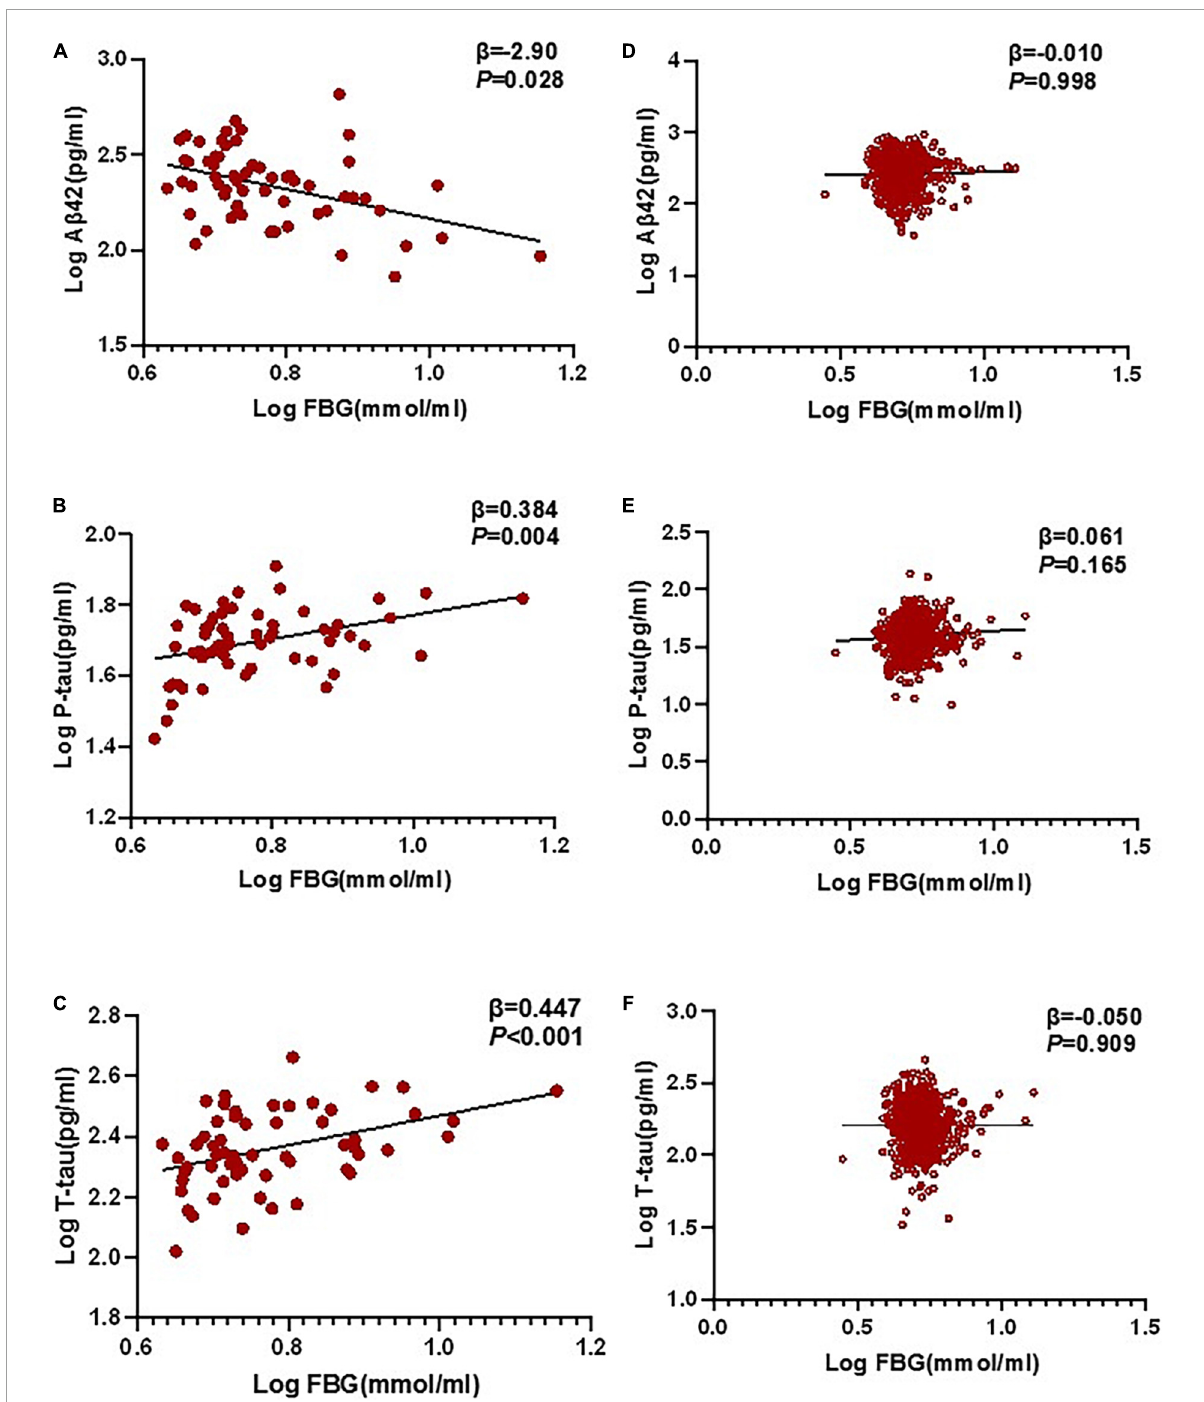
FIGURE3 Relationship between POD and biomarkers in CSF by multivariable linear regression. In the POD group, higher preoperative FBG levels were negatively correlated with CSF A β 42 level ( β = –0.290, P = 0.028), and positively correlated with CSF P-tau ( β = 0.384, P = 0.004) and T-tau ( β = 0.447, P < 0.001) in the non-diabetic older patients (A–C) . In the N-POD group, higher preoperative FBG levels were not associated with CSF biomarkers (D–F) . FBG and all CSF variables in linear regression models were log-transformed to normalize the distributions. FBG, fasting blood glucose; A β 42, β -amyloid42; T-tau, total tau; P-tau, phosphorylated